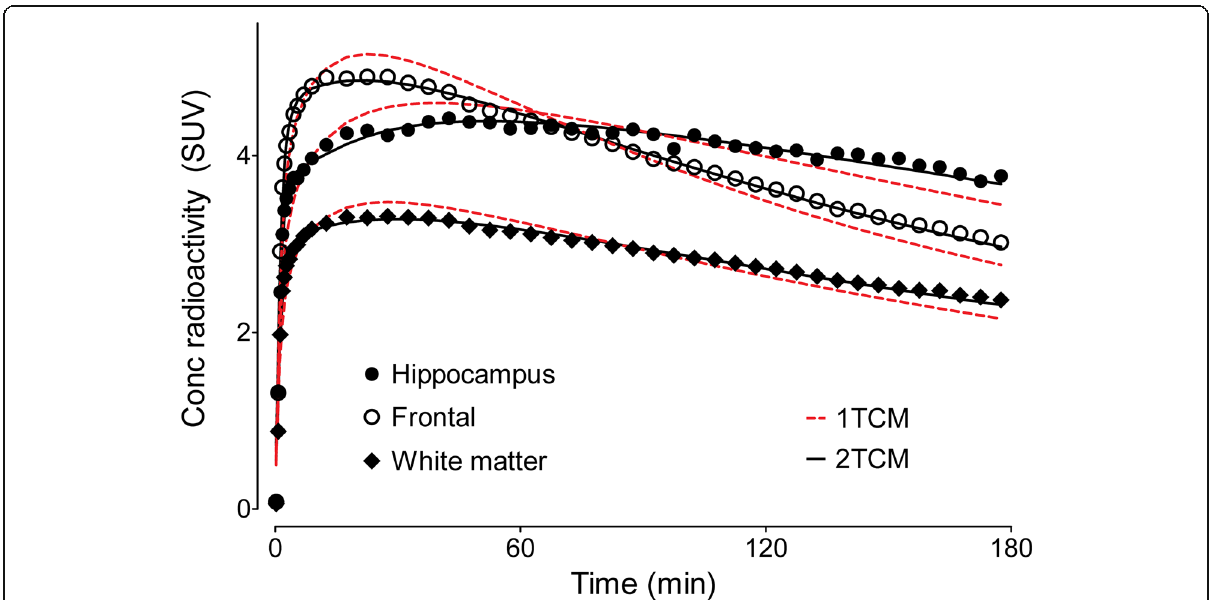
Fig. 4 Pharmacokinetic fitting of brain time-activity curves using one- and two-tissue compartment models. The two-tissue (2TCM, black lines) compartment model better fit the measured standardized uptake values (SUV) than the one-tissue (1TCM, red dotted line) compartment model, both visually and